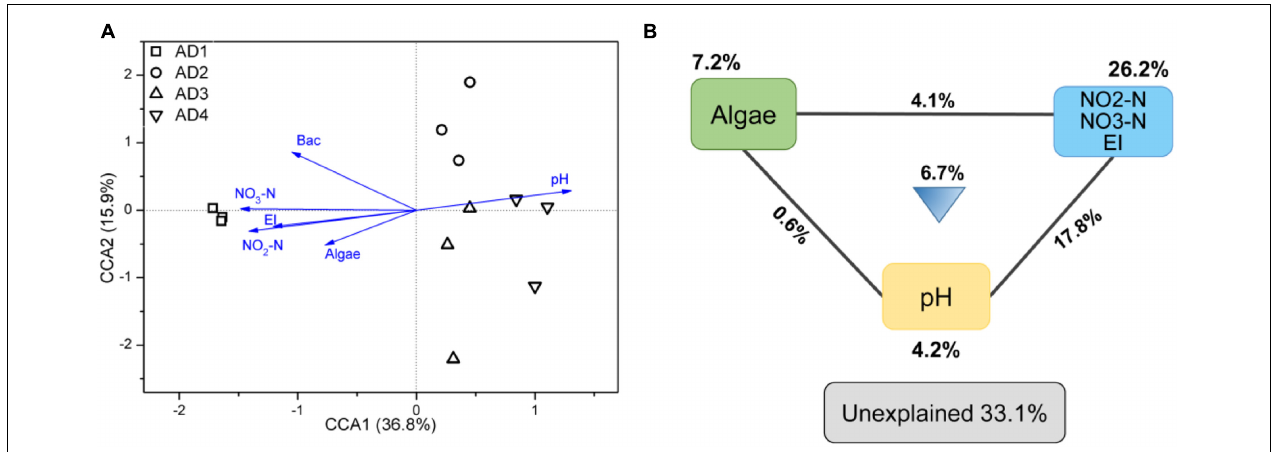
FIGURE 4 | Canonical correspondence analysis (CCA) of FLB with selected environmental variables (A) and partial CCA-based variation partitioning analysis (VPA) (B) . Selected environmental variables include pH, nitrate nitrogen (NO 3 -N), nitrite nitrogen (NO 2 -N), bacterial density (Bac), algae, eutrophication index (EI). Each diagram represents biological variation partitioned into the relative effects of each factor or a combination of factors.